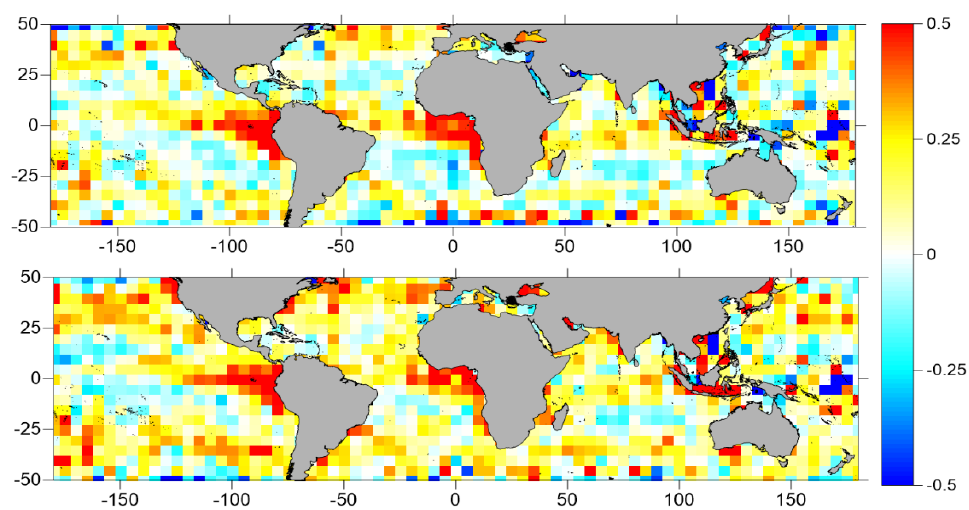
Figure 8. Differences, in cm, between RMS values for Op. 3I NN—Algorithm 2 ( top panel), and Op. 3I NN—Algorithm 4 ( bottom panel), represented with a 5 ◦ by 5 ◦ spatial resolution.